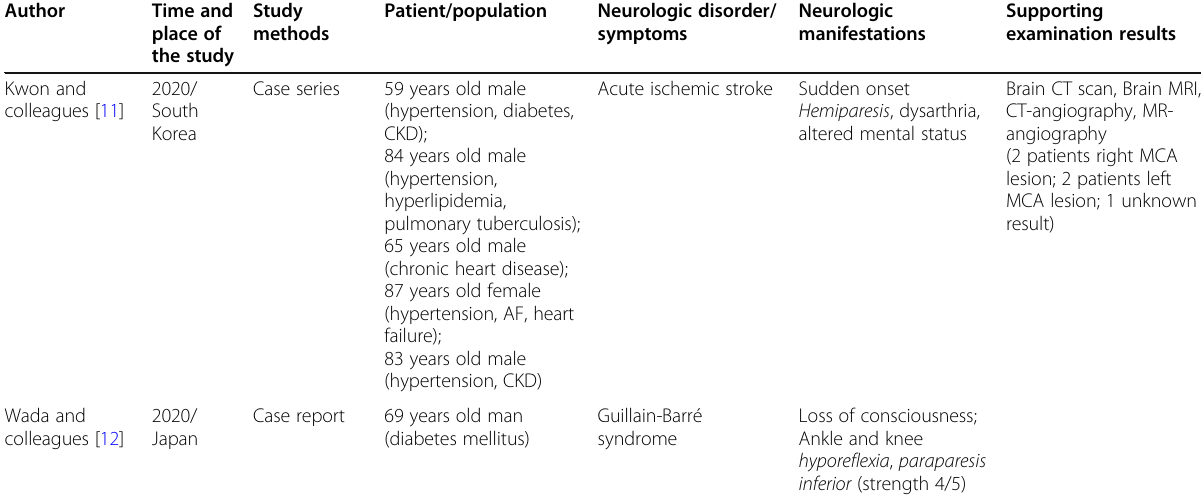
Table 1 Neruologic manifestation of COVID-19 infection according to publications included